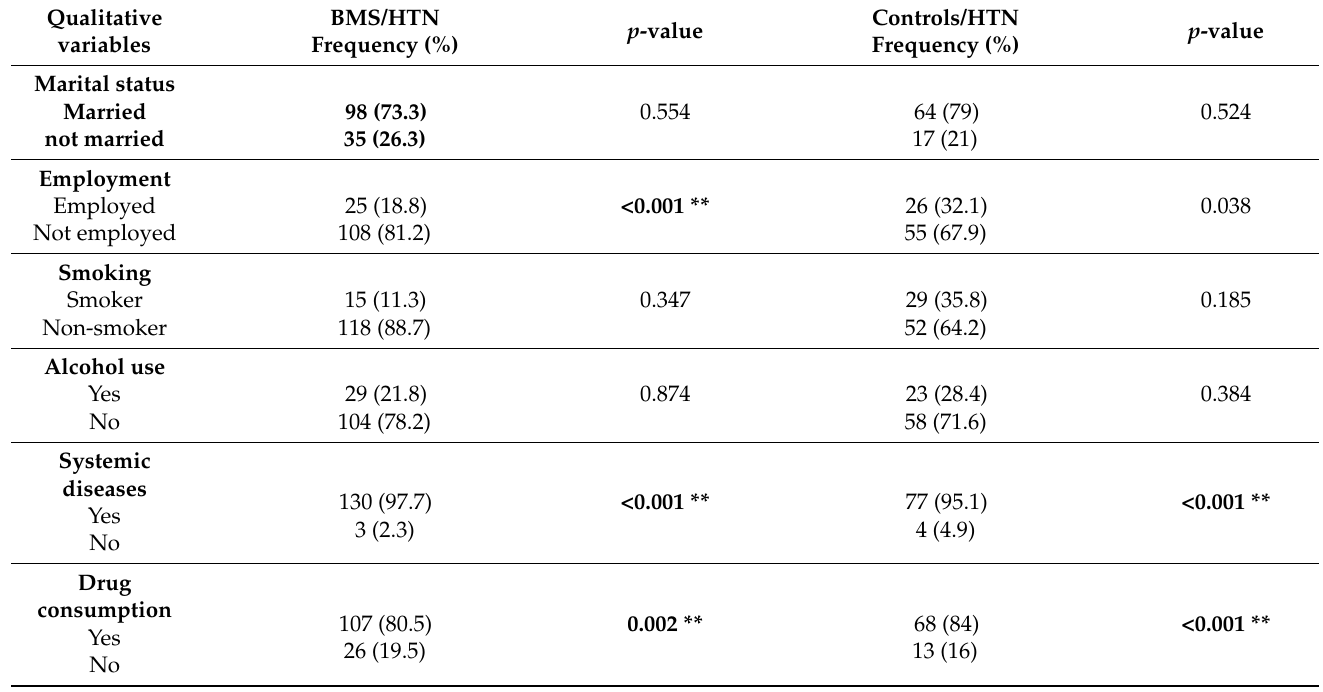
Table 5. Dependence analysis of 242 BMS patients and 242 controls with HTN and qualitative and quantitative